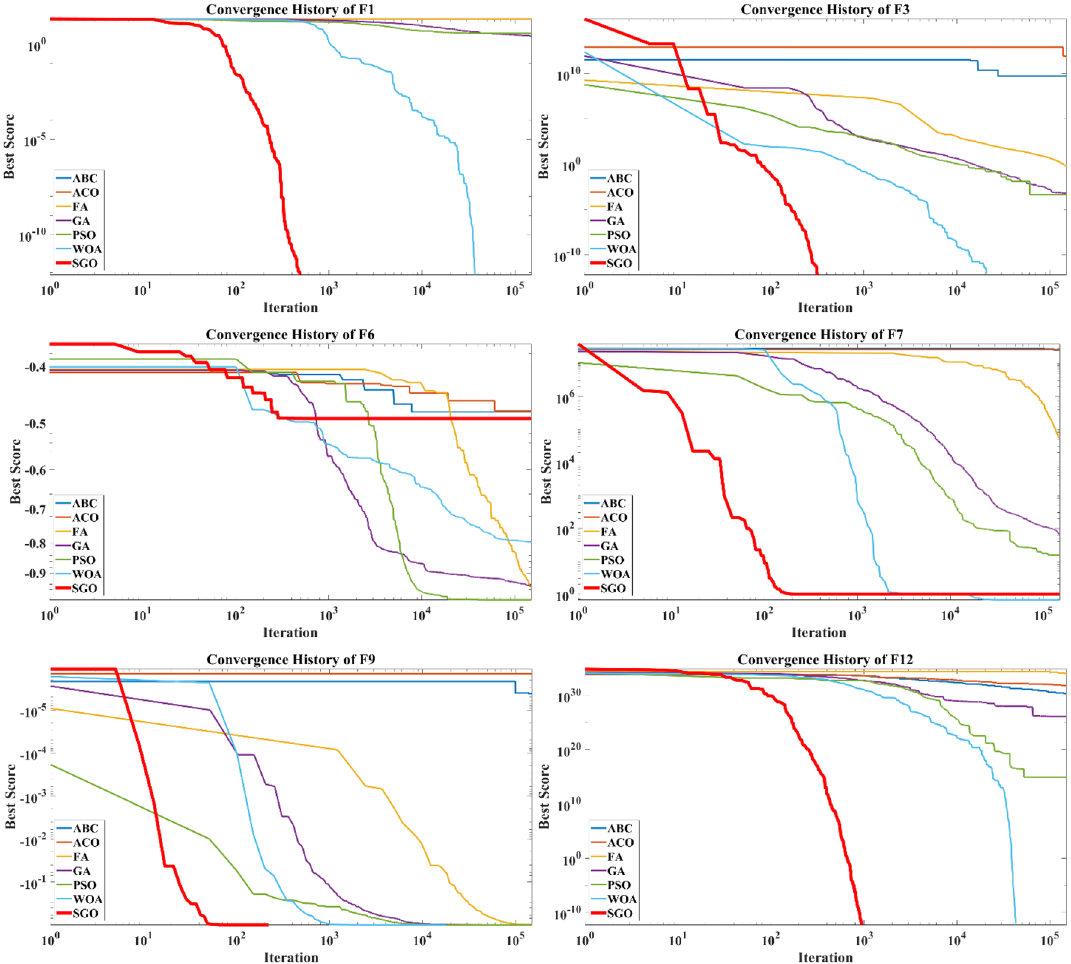
Figure 4. Convergence curves of metaheuristics regarding the median